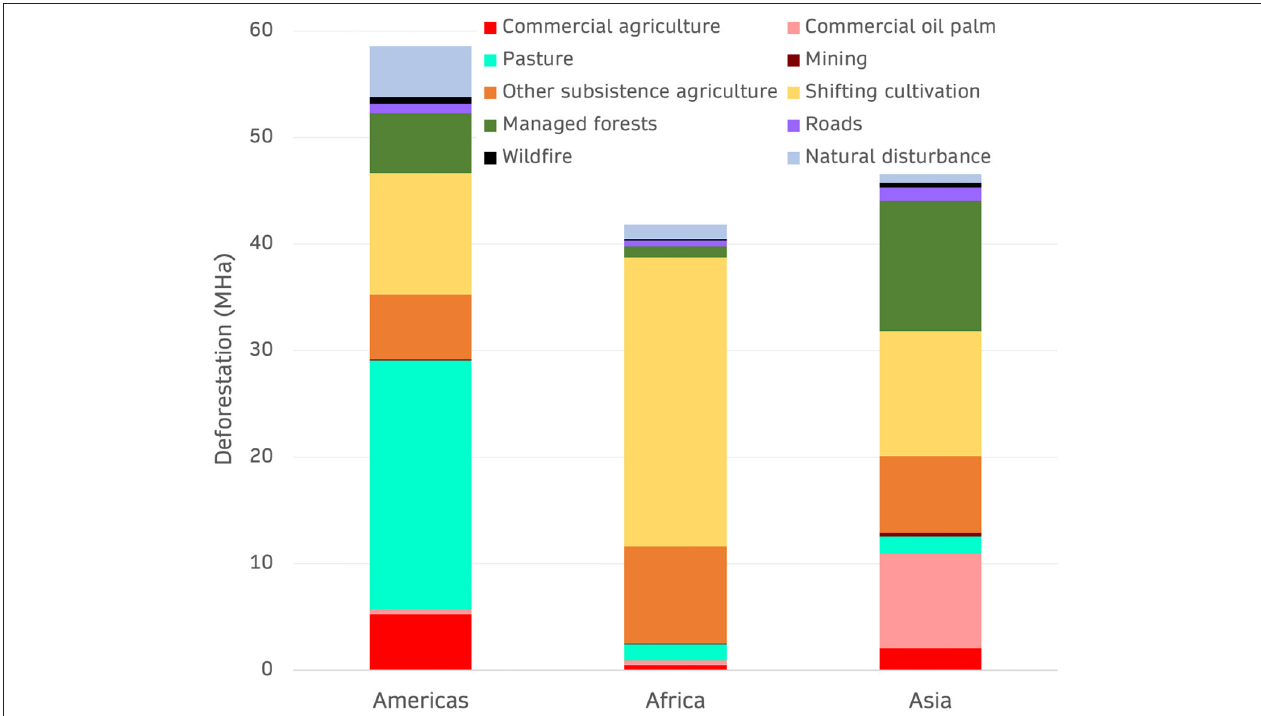
FIGURE 3 | The amount of deforestation (in MHa) by driver in the Americas, Africa, and Asia in the area 30 ◦ latitude north and south of the